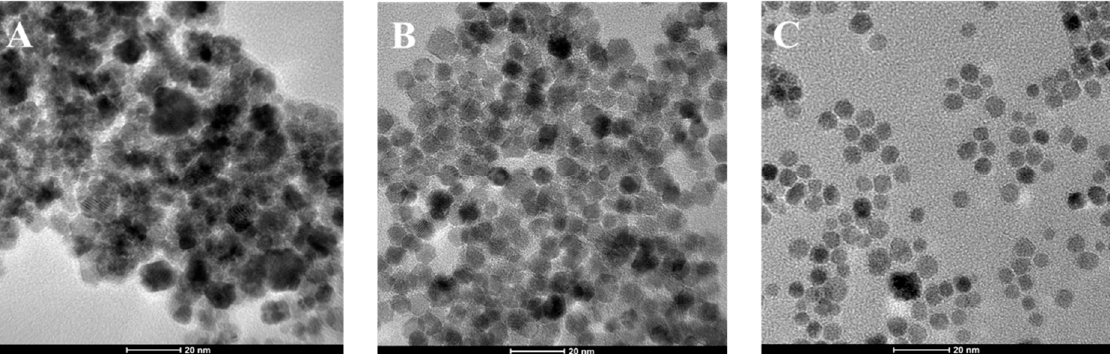
Figure 3. ( A ) TEM image of CeO 2 _OC_150, ( B ) TEM image of CeO 2 _OL_150 and ( C ) TEM image of CeO 2 _OL_250 NPs (scale bar: 20 nm).